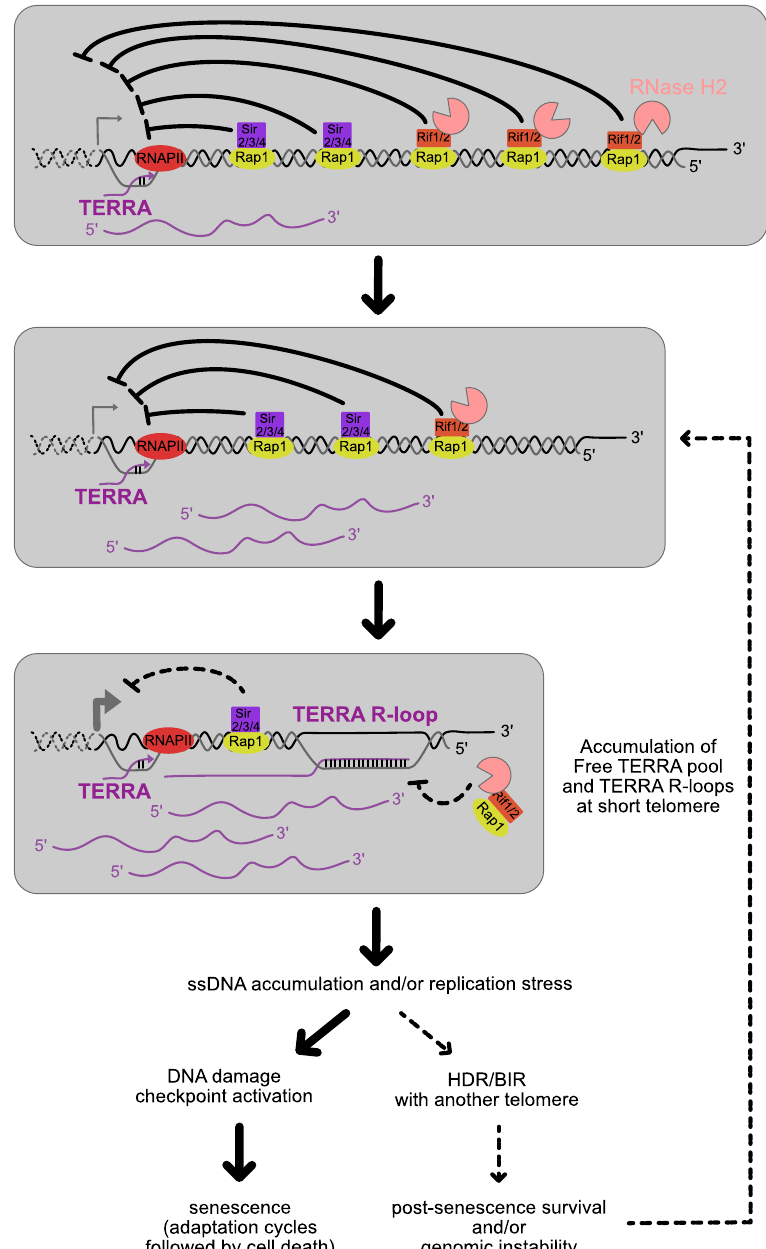
Figure 4. In the absence of telomerase, telomeres shorten gradually at each cell division. Free TERRA levels and TERRA R-loops increase at short telomeres due to the loss of the regulation in cis described in Figure 1. This generates structures that are prone to replication stress and/or recognized as DNA damage. A possible scenario is that at this point most cells undergo senescence, but in a tiny fraction the short telomeres may undergo a successful re-elongation via HDR with another longer telomere. Because these cells outgrow very fast the others, promoting or perturbing this process by introducing mutations, is expected to affect the rate of senescence. This process restarts again for each telomere reaching a critical short length.